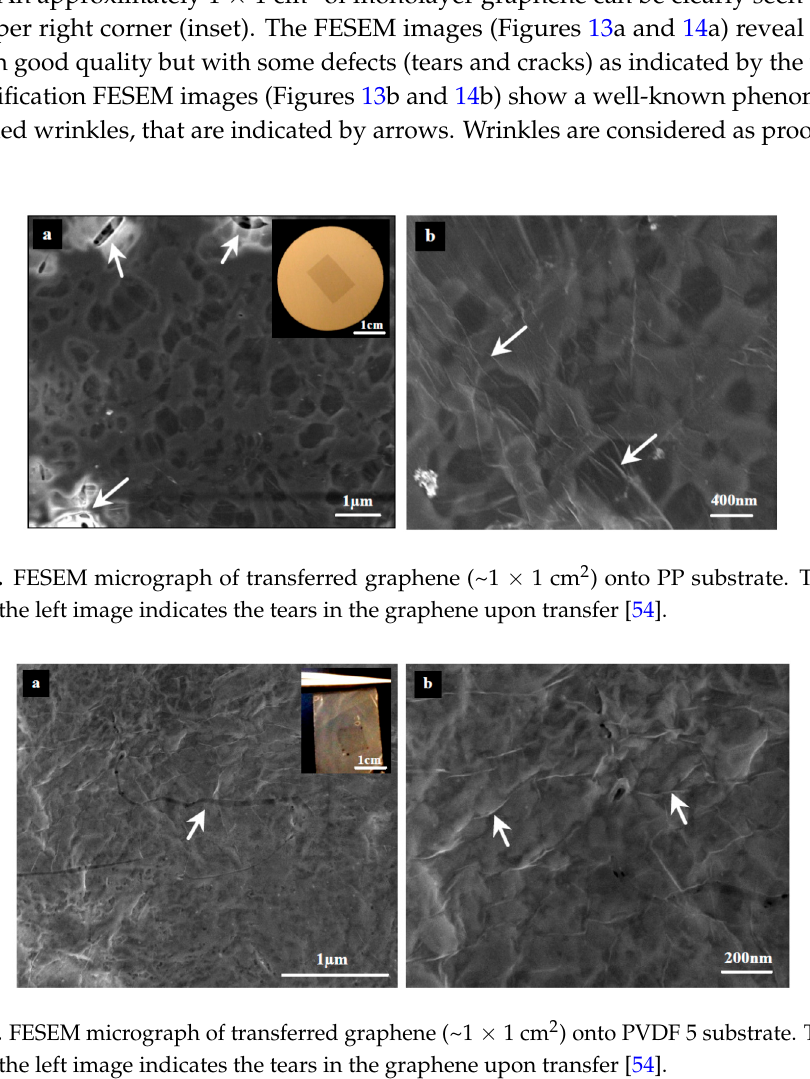
10 of 15 Figure 12. Copper/graphene and PVDF 1 substrate detachment process during copper etching step in